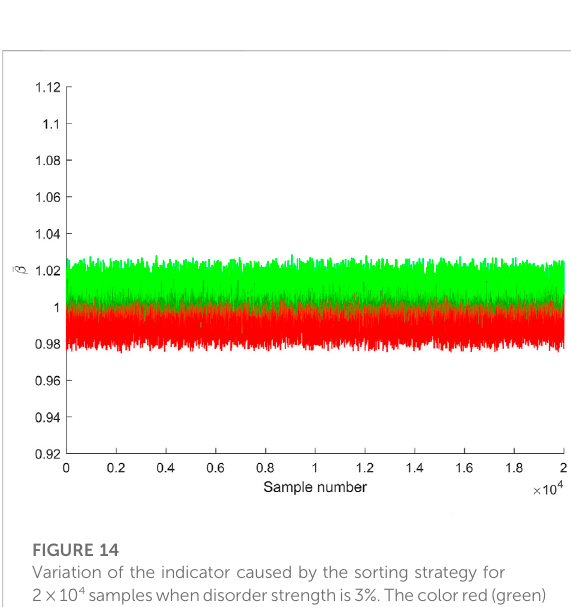
FIGURE 12 Variation of indicator caused by the sorting strategy for 2 × 10 4 samples when disorder strength is 10%. The color red (green) means an increase (decrease) of value.